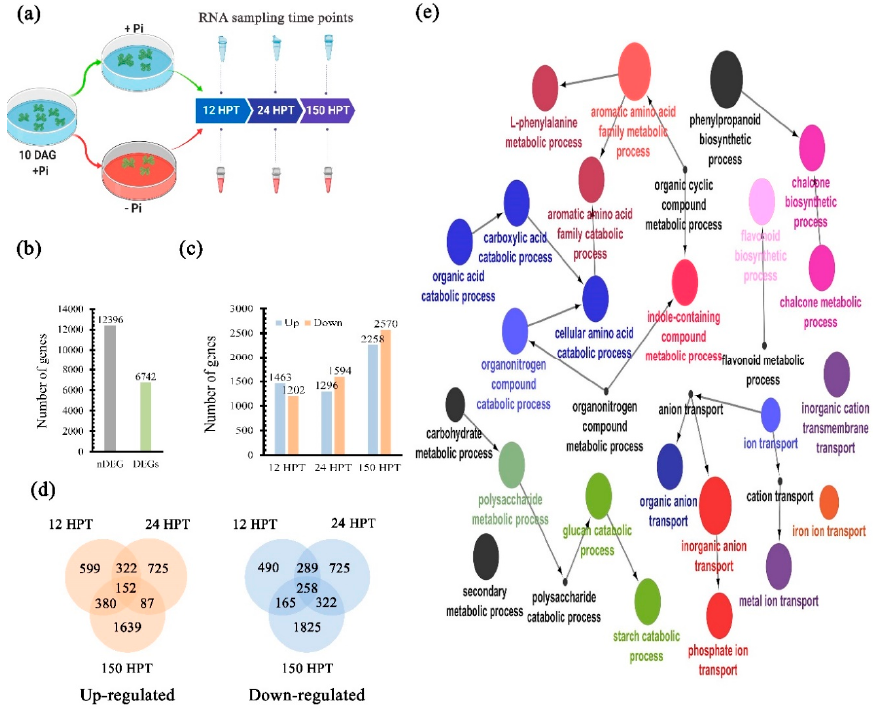
Figure 3. Dynamics of transcriptional responses to Pi starvation. ( a ) Graphic description of the experimental design for the RNA-seq approach. ( b ) Differentially expressed genes (DEGs) and non- differentially expressed genes (nDEGs). ( c ) Bar plot showed the up-regulated genes in light red and the down-regulated ones in green for each time of the transcriptome. ( d ) Venn diagrams for up- regulated (Red) and down-regulated (green) genes for each condition. ( e ) Clustering of over- represented Gene Ontology (GO) categories in the genes up-regulated in response to low Pi availability, color clustered similar categories and circle size correlates with the P-value of enrichment test.